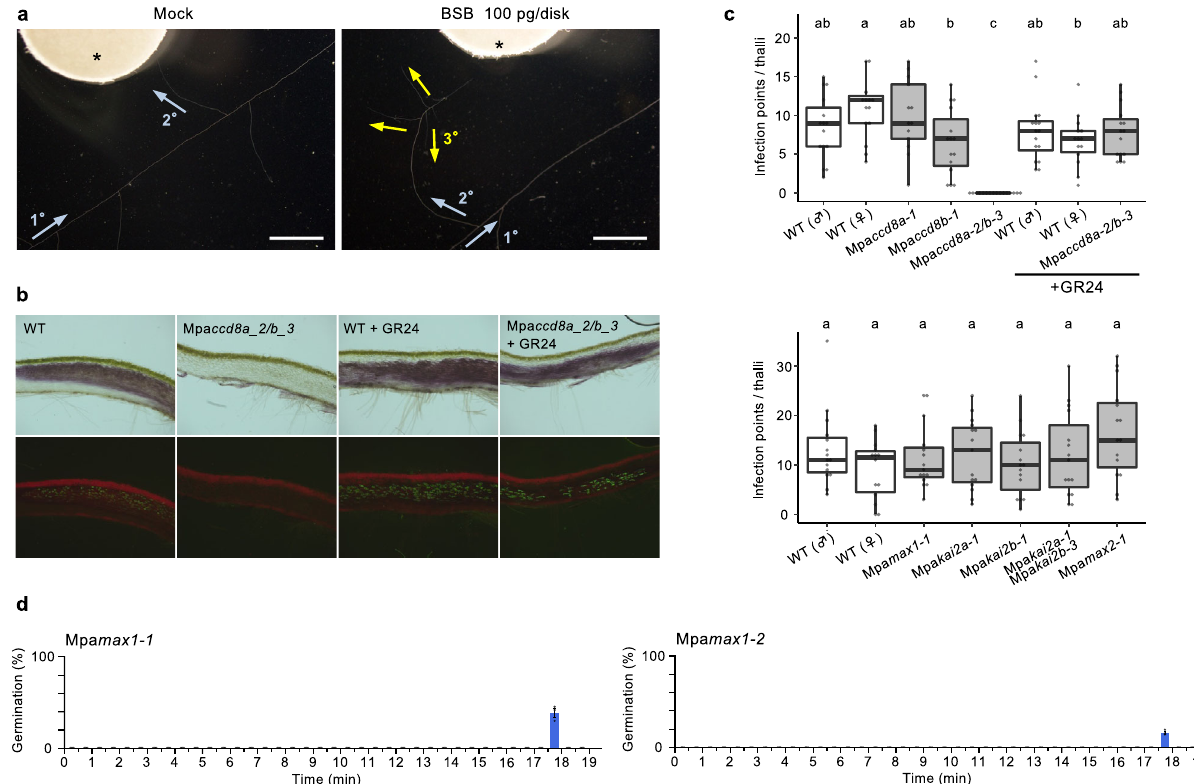
Fig. 5 BSB is required for symbiosis with AM fungi in M. paleacea . a Hyphal branching of Gigaspora margarita induced by BSB (100 pg per disk) using the paper disk diffusion method. Arrows indicate the direction of growth of primary, secondary and tertiary hyphae. Asterisks indicate paper disks. Experiment was repeated three times with similar results. b Upper and bottom panels are transverse sections of colonization by Rhizophagus irregularis . The bottom panels show WGA-FITC staining of the fungi. Experiment was repeated three times with similar results. Scale bars: 0.5 mm. c The number of infection points per thalli ( n ≥ 13 biologically independent plants). Box plot shows fi rst quartile, median, third quartile, whiskers 1.5 interquartile. Letters show different statistical groups ( p values < 0.05, one-way ANOVA, post hoc Tukey). d Germination stimulation activity on root parasitic plants of the exudates of the Mpa max1 mutant. The exudates of the two alleles were separated by reversed-phase HPLC. Every 30 s all the fractions were tested for seed germination activity on Orobanche minor . Data are means ± SE ( ∼ 30 seeds per disk, n = 3). The seed germination activity (%) of rac -GR24 (10 − 8 M) was 99.4 ± 0.6 on O. minor